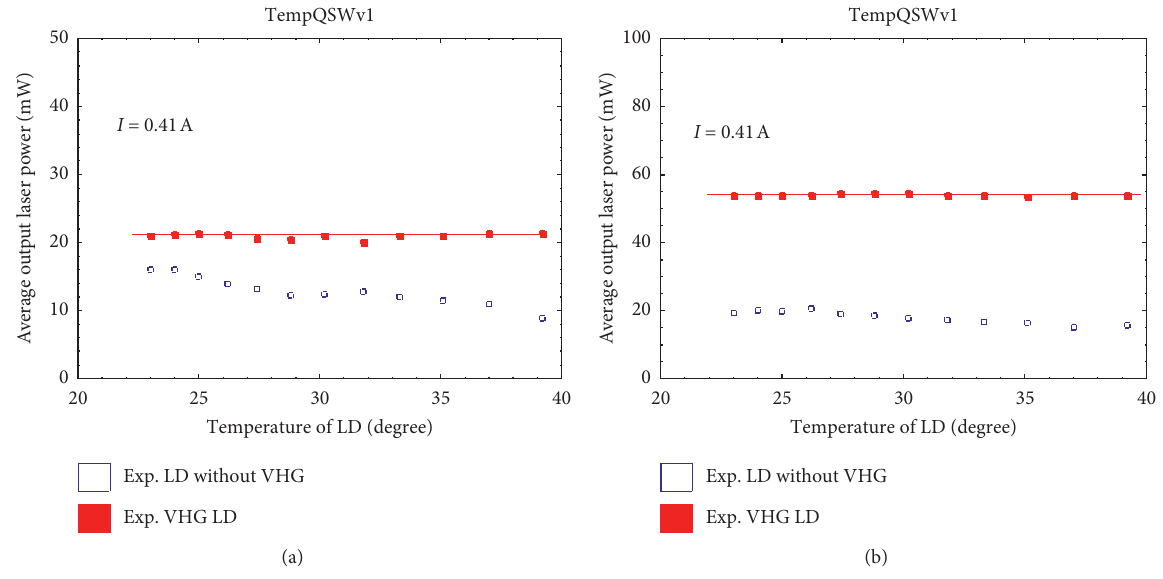
Figure 10: Stability of laser power for LD temperature: (a) Nd:YAG and (b) Nd:YVO